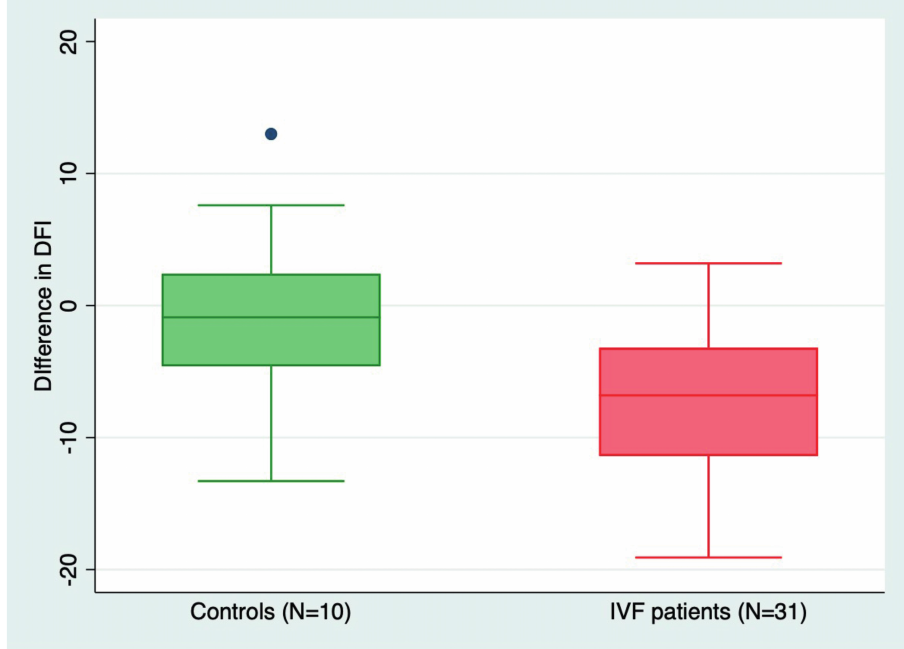
Figure 2 - Boxplots showing the difference between sperm DNA fragmentation (DFI) measurements of 10 healthy controls who delivered two semen specimens within a 14-day interval and 31 IVF patients with baseline DFI >15% who had lifestyle intervention and antioxidant therapy for 3 months. The boxplot includes the median (horizontal line in the box), 25-75% interquartile range box (i.e., representing 50% of the data), minimum and maximum values excluding outliers (whiskers extending outside of the box), and outlier (blue dot). The DFI differences between the groups were significant (P